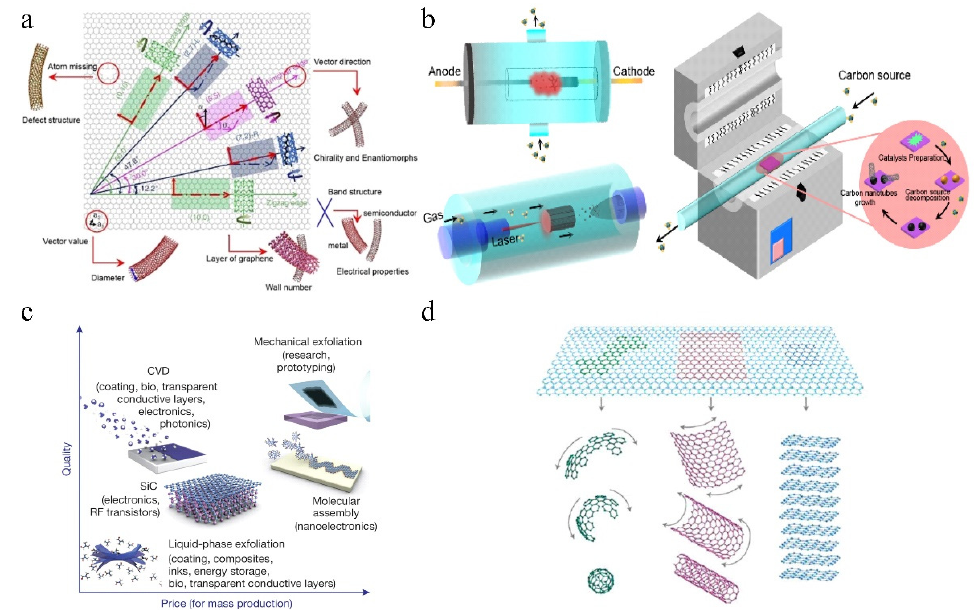
Figure 3. ( a ) Classification of carbon nanotubes (CNTs). ( b ) Techniques employed for the synthesis